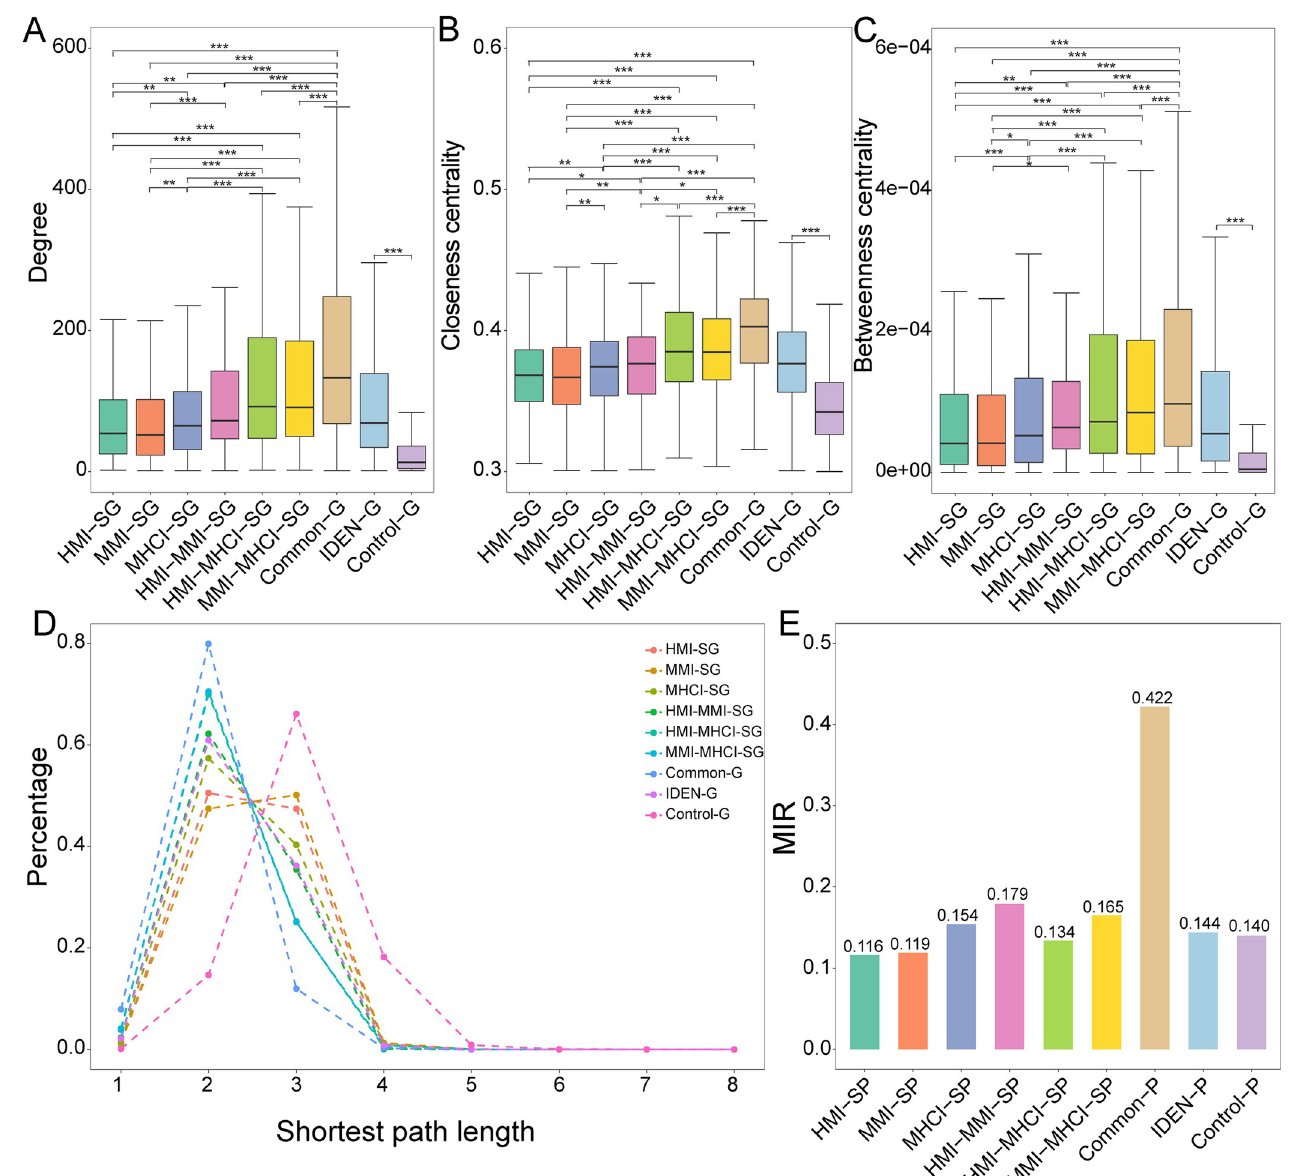
Fig 5. Network topology features of disease-related genes. (A) Degree centrality. (B) Closeness centrality. (C) Betweenness centrality. (D) Shortest path length. (E) MIR measure. ��� P < 0.001, �� 0.001 � P < 0.01 and � 0.01 � P <